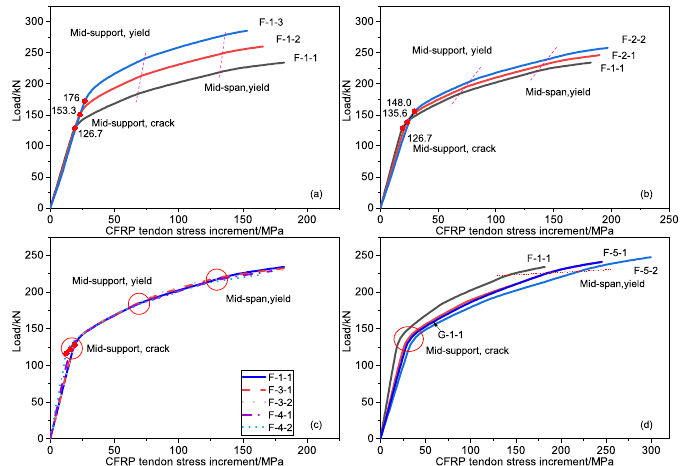
Figure 9. The curve of load and stress increment: ( a ) the initial prestress value the tendons, ( b ) the cross-sectional area of the tendons, ( c ) the cross-sectional area of the reinforcements and the eccentric- ity of the tendons, ( d ) the elastic modulus of the steel strand and the tendons.